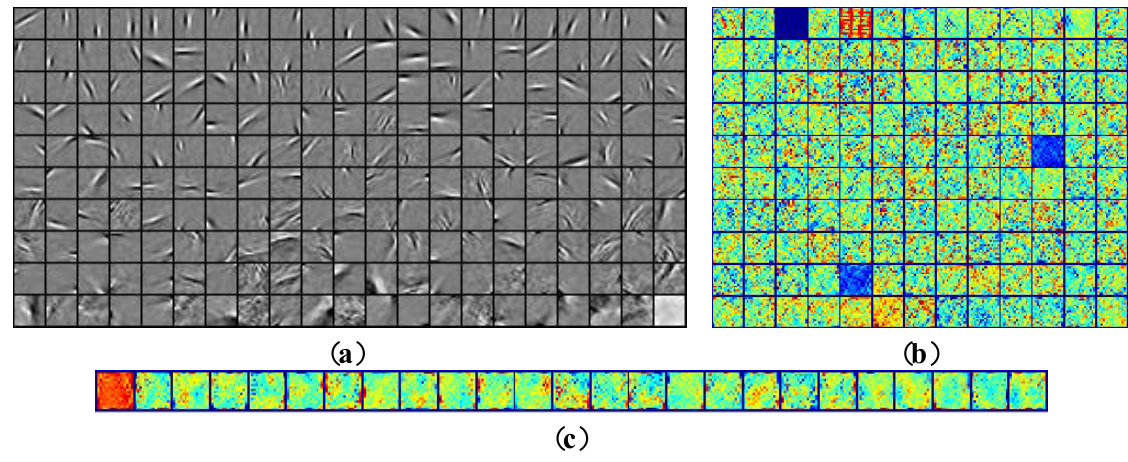
Figure 9. The basis functions. ( a ) Basis functions in the 1 st layer; ( b ) Basis functions in the 2 nd layer; ( c ) Basis functions in the 3 nd layer.